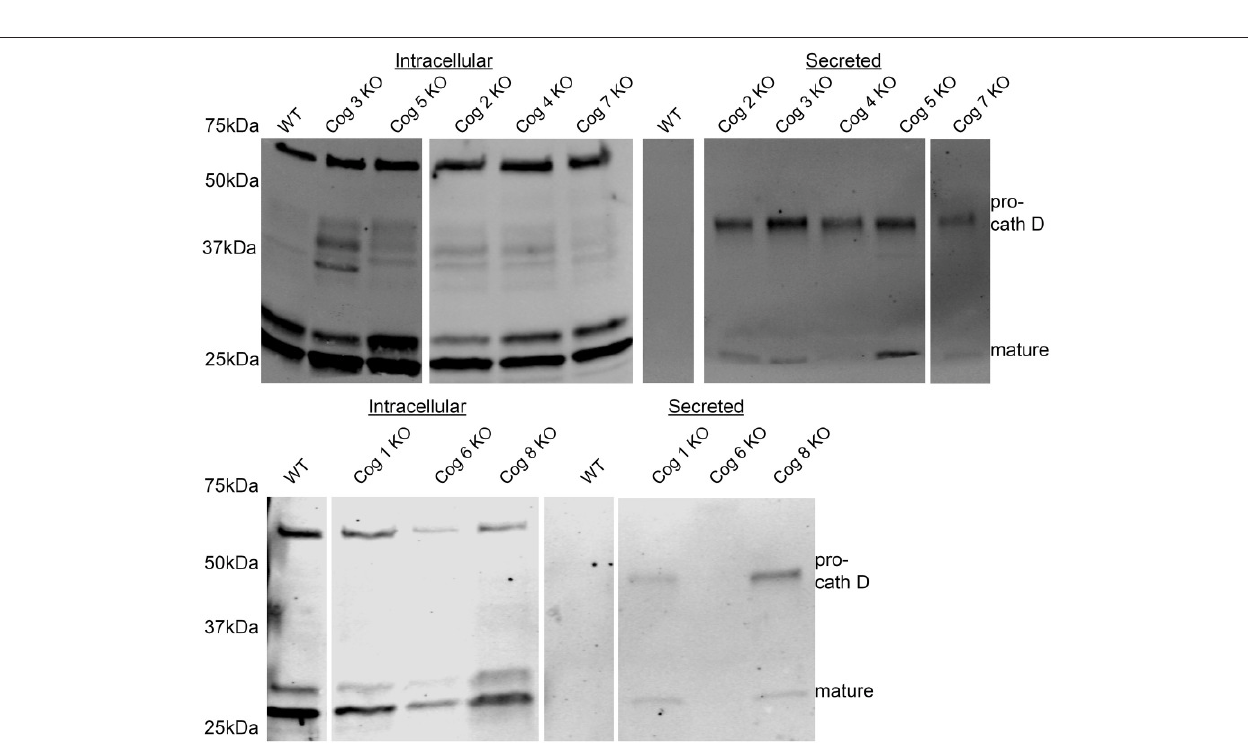
D. Because Cog6 KO was the only outlier for immature Cathepsin D secretion we tested another Cog6 KO clone which yielded a similar result (data not shown), though further analysis of this cell line and generation and analysis of more Cog6 KO cell lines will be needed in the future to confirm this